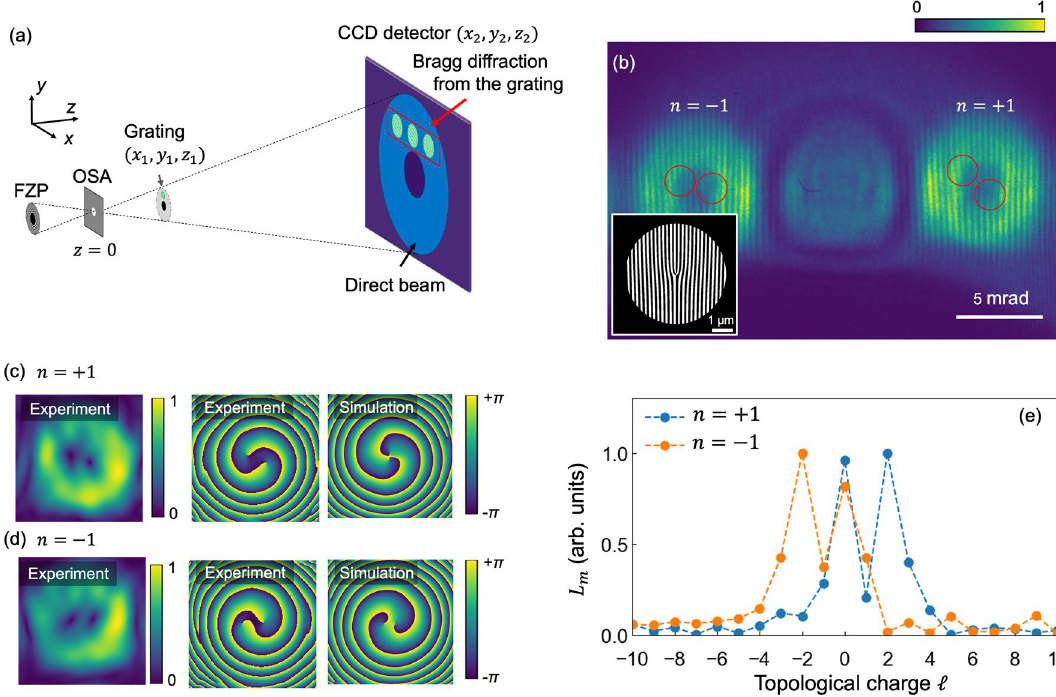
Figure 1. ( a ) Schematic of the experimental setup for soft X-ray inline holography. Incident X-rays are focused via a Fresnel zone plate (FZP). The first-order diffraction from the FZP is selected by an order sorting aperture (OSA) placed in the vicinity of the focal point. A grating placed downstream of the focal point produces Bragg diffraction waves, which interfere with direct waves transmitting outside the grating. The interference pattern is observed at the CCD detector as a holographic image. ( b ) Hologram pattern from the fork grating with b = 2 shown in the inset. Red circles indicate fork shaped patterns. ( c , d ) A (ρ fn , φ fn ) (first column) and phase distribution (second column) of the vortex diffraction waves for ( b ) n = + 1 and ( c ) n = − 1 , as obtained using spatial frequency filtering (refer to the main text). Figures in third column present simulated phase patterns for these vortex diffraction waves. ( e ) TC spectra for the nb = ± 2 diffraction waves obtained using the method described in the main